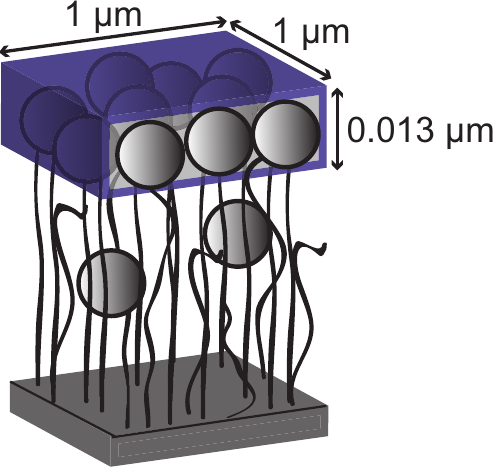
Figure 9. Determination of XRR particle number densities by using a box